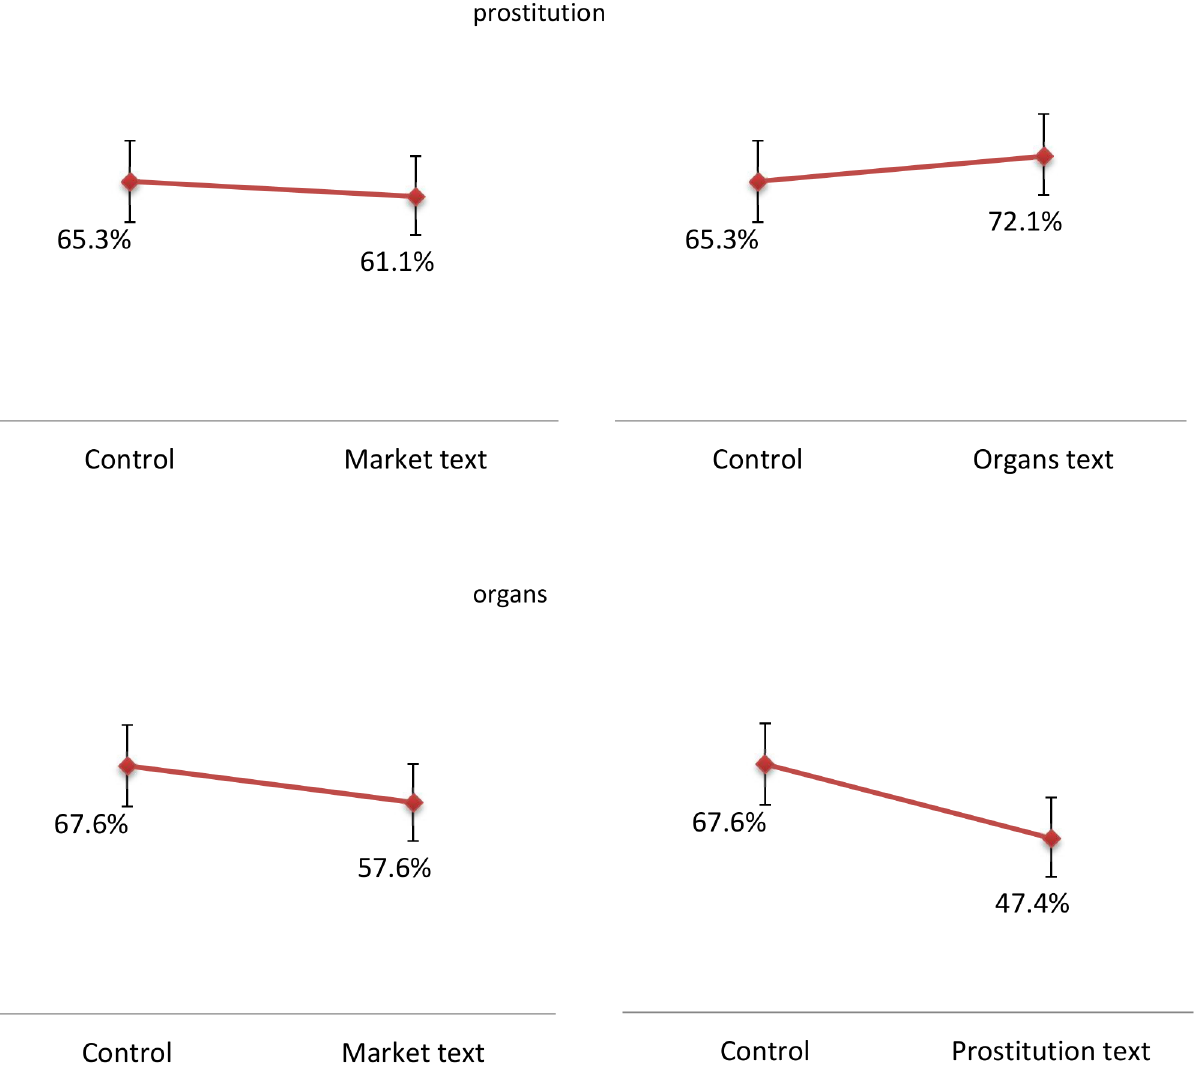
Fig 2. Estimated treatment effects. Notes: The figures report the percentage of subjects favoring either payments for organs or legalizing indoor prostitution, by treatment condition. The values were calculated as the differences between the average number of statements with which the subjects were in agreement when provided with five statements (including the statement about support for payment for organs/indoor prostitution) and the average number of statements with which the subjects were in agreement when provided with four statements (excluding the statement about support for payment for organs/ indoor prostitution). The vertical bars indicate 95% confidence intervals for the